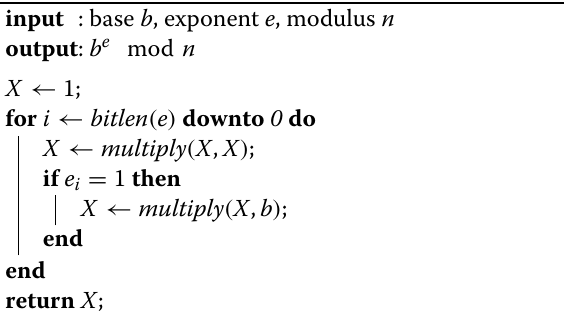
Algorithm 1: Square-and-multiply